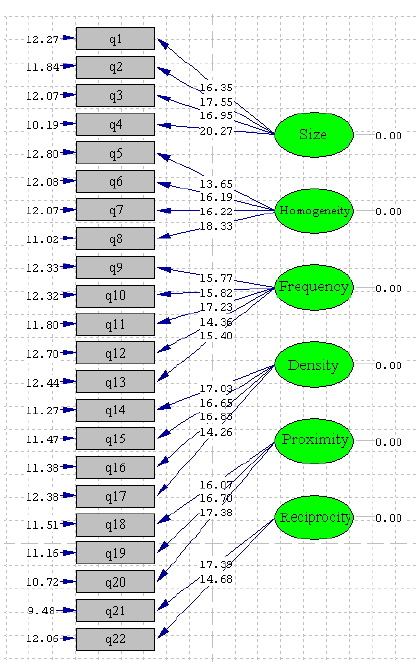
The results of t-values